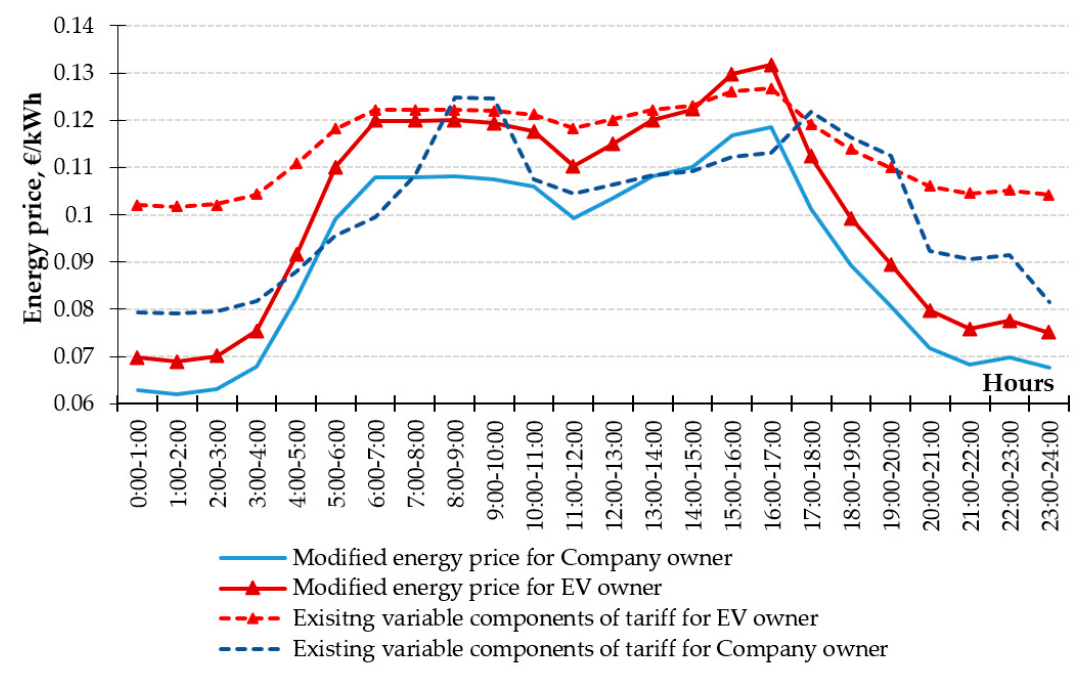
Figure 5. Consumers’ energy prices, for one day (6 January 2018).